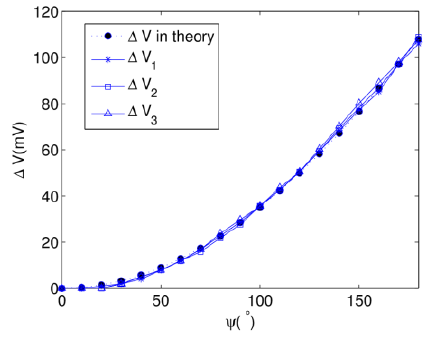
Figure 12. Estimation of torsion angle ψ